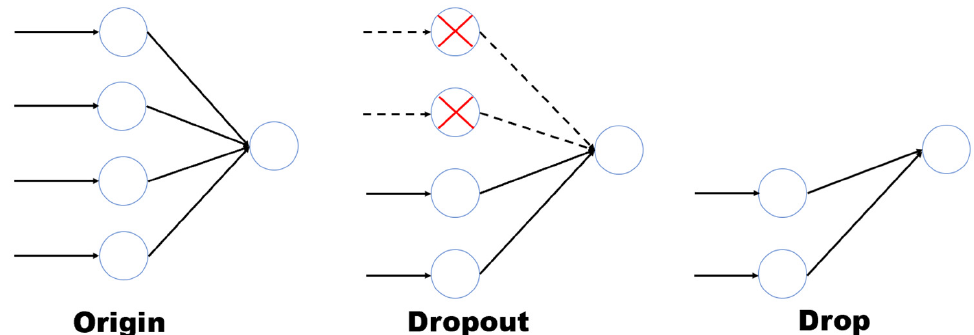
Figure 2. The difference between Dropout and